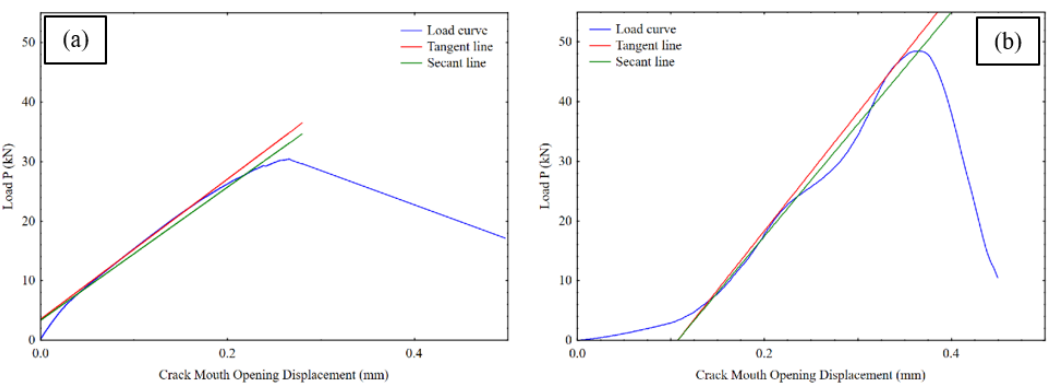
Figure 8. Load-crack mouth displacement curves used for the determination of K Q : experimental testing ( a ) and simulation ( b